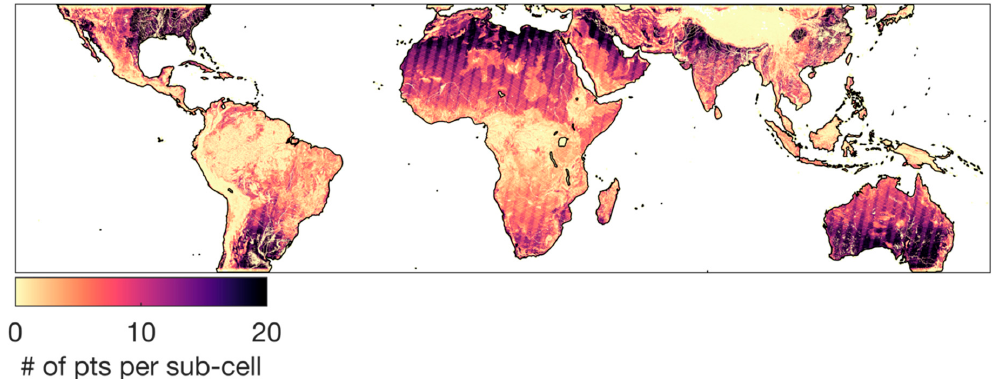
Figure 5. The number of CYGNSS observations for each sub-cell that were used for calibration. Fewer observations are found in higher elevation areas, which did not have data for most of 2017. Observations over open water have already been removed.